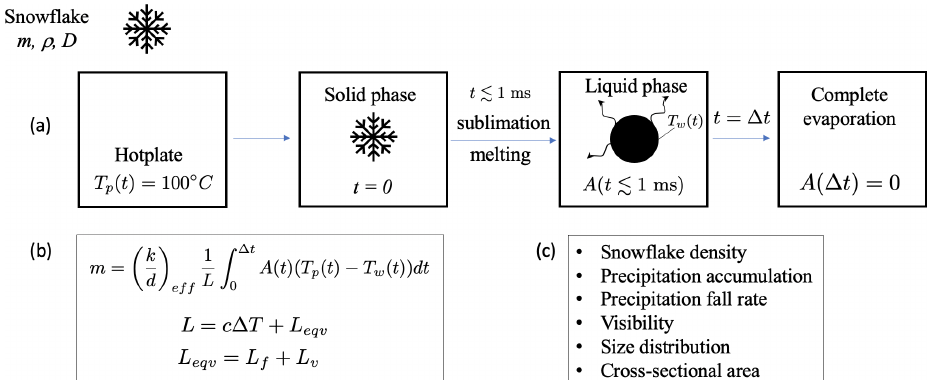
Figure 3. (a) Schematic illustrating the process of a snowflake falling onto the hotplate, melting and evaporating. (b) The DEID algorithm for measuring hydrometeor mass: c is the specific heat capacity of water, (cid:49)T is the temperature difference between the initial and final water-droplet temperature, L f is the latent heat of fusion (e.g., sublimation), L v is the latent heat of vaporization, and L eqv is the total latent heat of vaporization and fusion. (c) Output products deduced from the DEID